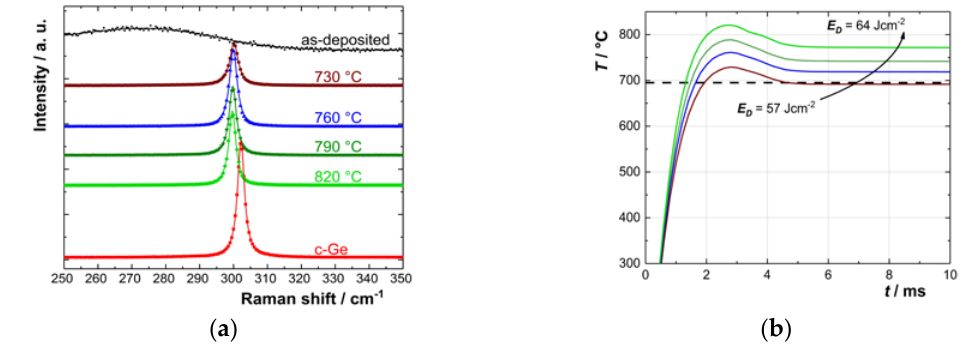
Figure A1. ( a ) Spectra of as-deposited a-Ge, poly-Ge, and c-Ge obtained from Raman scattering measurements. ( b ) Simulation of the annealing temperature of a 1D a-Ge/SiO 2 /Si layer structure for a 3-ms flash pulse. The dashed line indicates the melting point of the a-Ge layer.